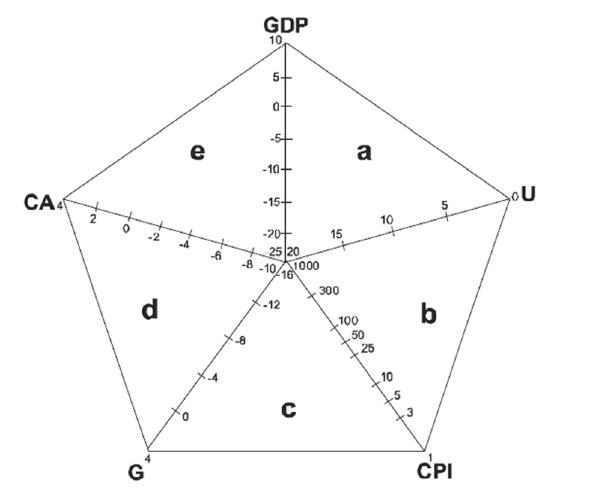
Figure 1. Macroeconomic stabilization pentagon (Kolodko,